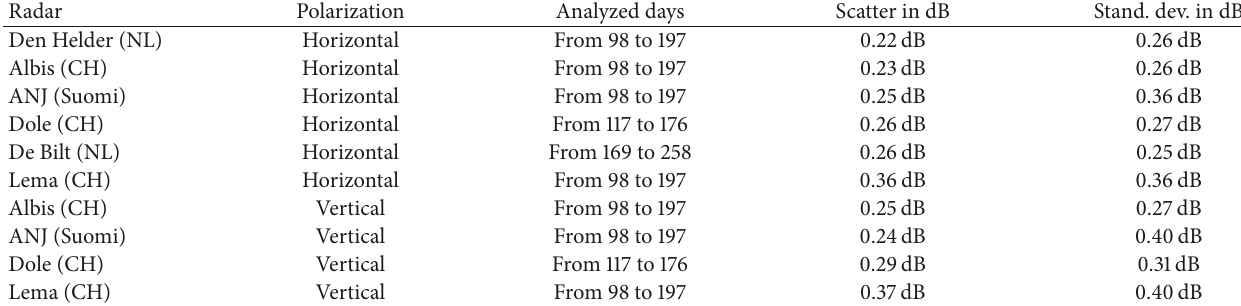
Table 2: Agreement between six radars in Europe and the DRAO reference in 2014.